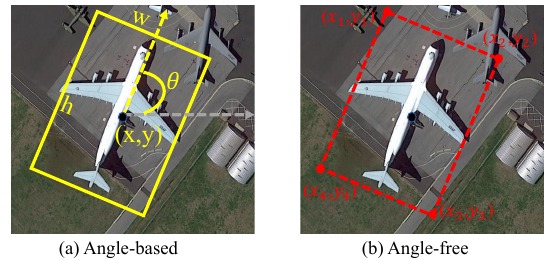
Figure 1. Comparison of angle-based and angle-free